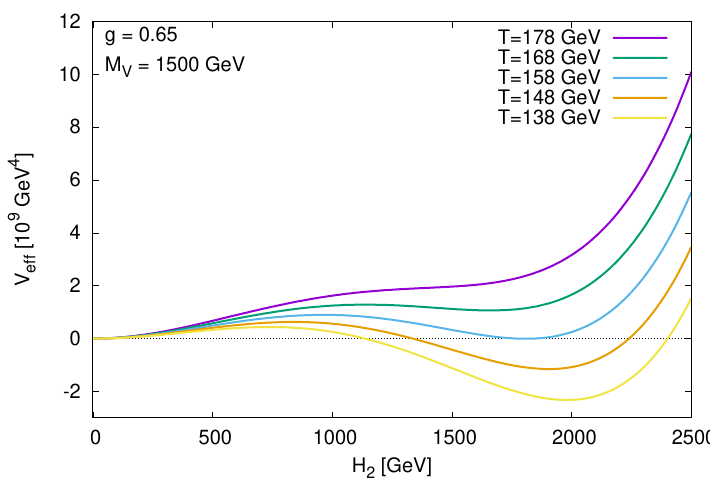
( H 2 ; T ) for e(cid:11)